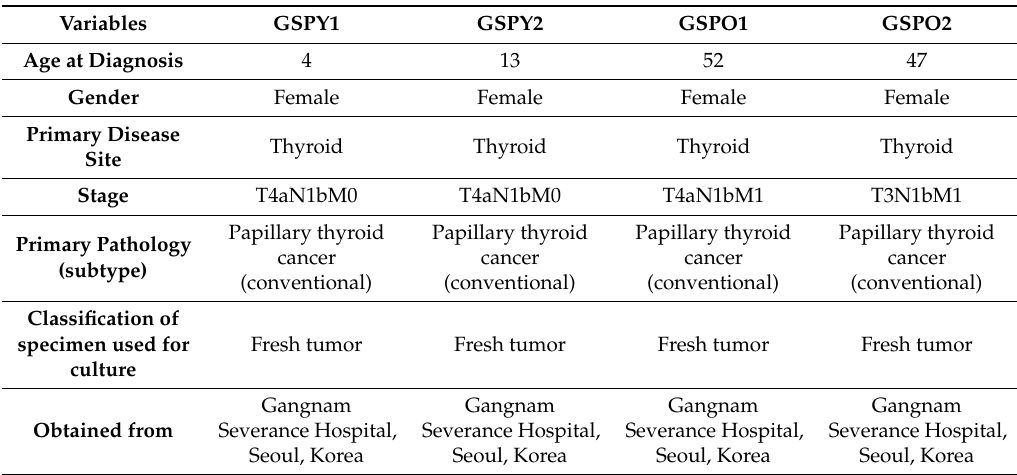
Table 2. Characteristics of patient-derived papillary thyroid cancer cell line, including viability after drug treatment of all thyroid cancer cell lines